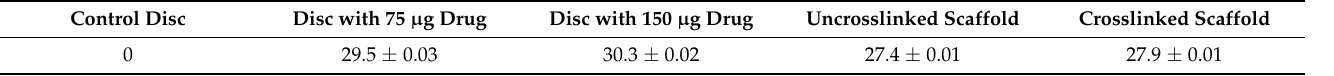
Table 4. The average diameter (mm) of the inhibition zone around the prepared scaffolds. Control